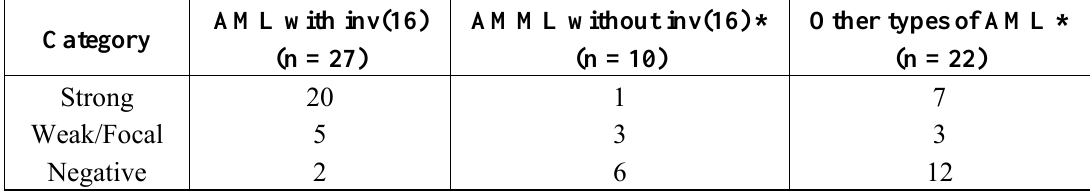
Table 3. Immunohistochemical CYP2E1 protein expression in AML with inv(16), AMML without inv(16) and other types of AML.